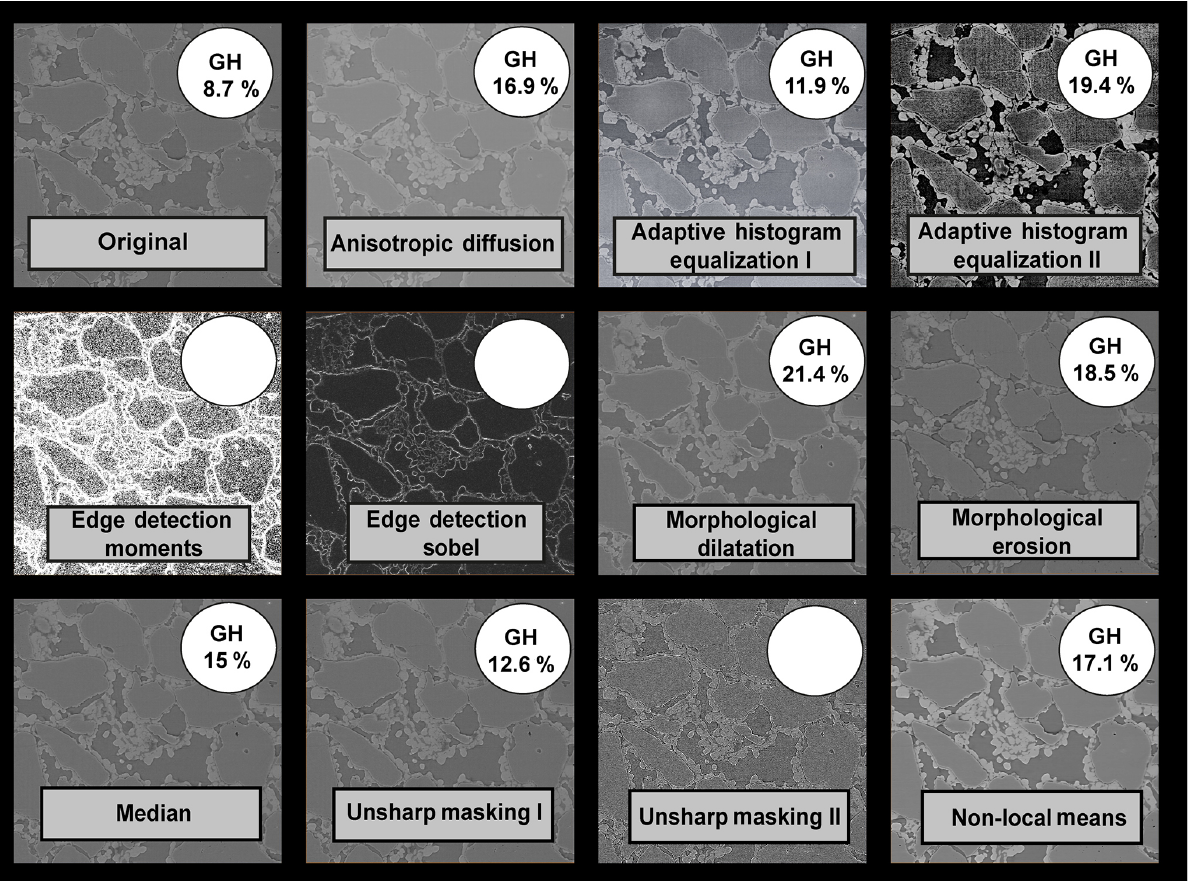
Figure 5. Selected filters applied to the original image to enhance the quality for further segmentation steps. Also, the results of the numerical estimation of hydrate content with the PoroDict module of GeoDict after arithmetic correction are depicted in the upper right corner. Blank circles indicate poor image quality where segmentation was not